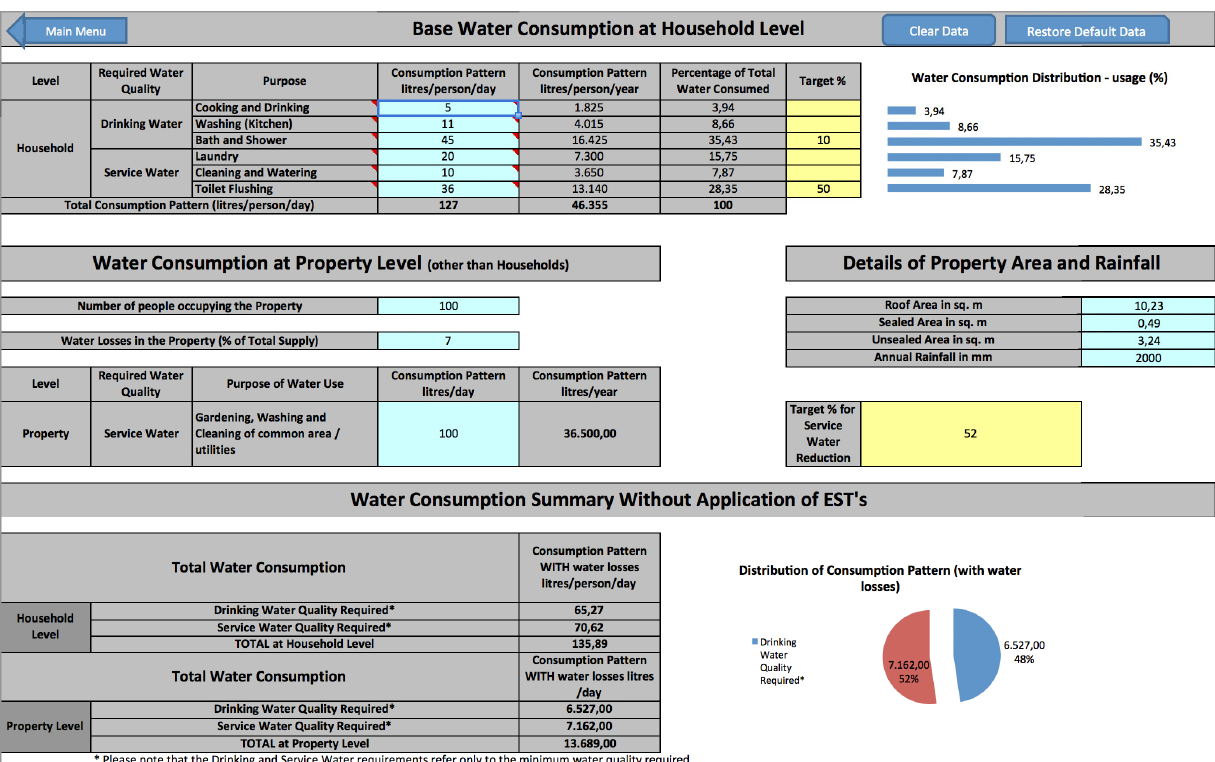
Figure 6. User interface of the “Base Water Consumption” sheet in “Wise Water”. In the blue and yellow marked cells, the user can change default data for “Base Water Consumption at Household Level”, “Water Consumption at Property Level”, and “Details of Property Area and